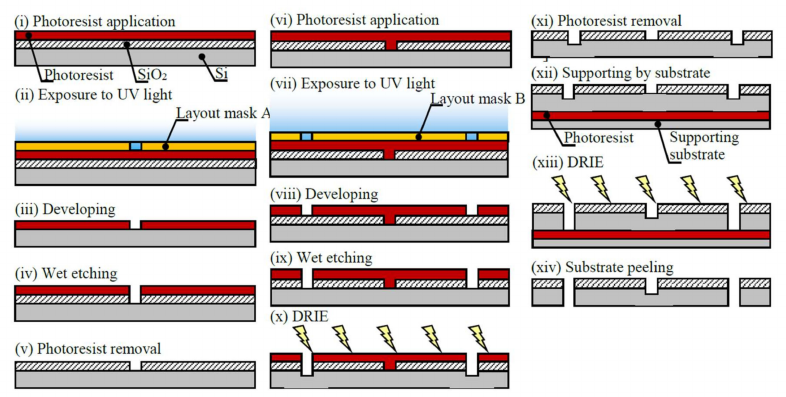
Figure 4. Photolithography with deep-etching of the disk-shaped resonator, including a two-step exposure process using layout masks A and